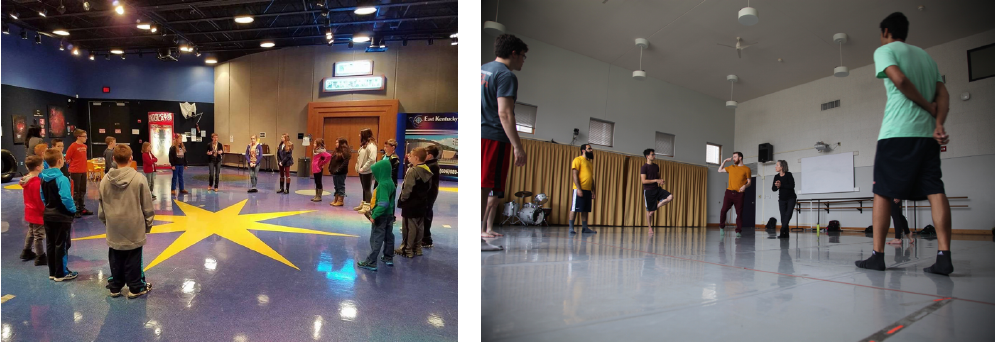
Figure 2. Two images of the beginning of a movement